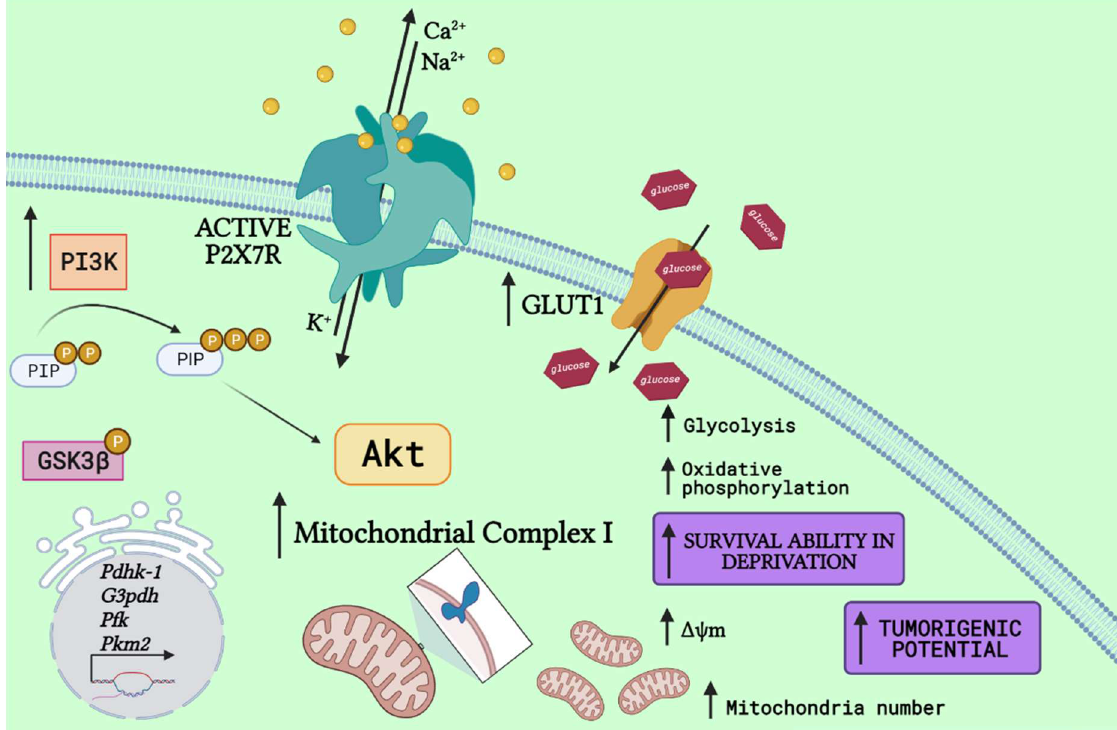
Figure 1. P2X7 receptor activation drives a metabolic shift. P2X7 receptor (P2X7R) activation drives PI3K activity, generating phosphatidylinositol (3,4,5)-trisphosphate (PIP3) and ultimately enhancing Akt signaling. Following, it drives upregulation of glycolytic-related enzymes, such as pyruvate dehydrogenase kinase-1 (PDHK-1) [72], a similar response to that observed in stem cells in the presence of glucose [62], and others, as glyceraldehyde 3-phosphate dehydrogenase (G3PDH), phosphofructokinase (PFK), and pyruvate kinase M2 (PKM2) [72]. Despite glycolytic improvements, the P2X7R is also related to increased expression of glucose transporters (GLUT) [72,73], increasing glucose uptake and oxidative phosphorylation, matched to higher expression of mitochondrial complex 1 and potential (Δψm), as well as mitochondria number [18] and increased glycogen storages through GSK3β phosphorylation [20]. Altogether, these metabolic shifts make cells highly capable of surviving in deprivation conditions and enhance the tumorigenic potential of cancer cells (Created with